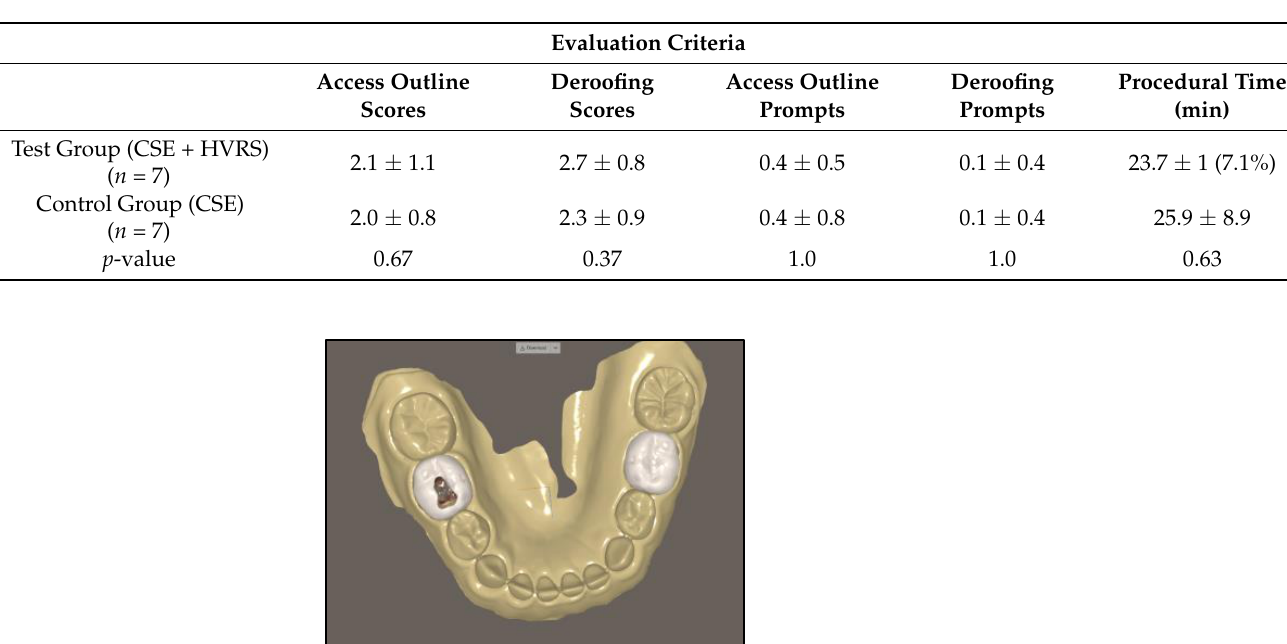
Table 1. Mean values ( ± SD) for each evaluation criterion of the study and control groups and results of the t -test.